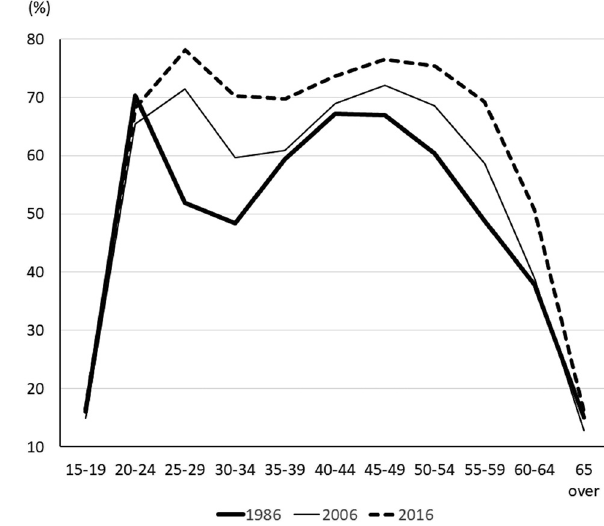
Figure 5: The proportion of elderly people ( aged 65 over ) who lived with their children ’ s family. The Fiscal 2017 White Paper on Health, Labour and Welfare. The Ministry of Health, Labour and Welfare of Japan.